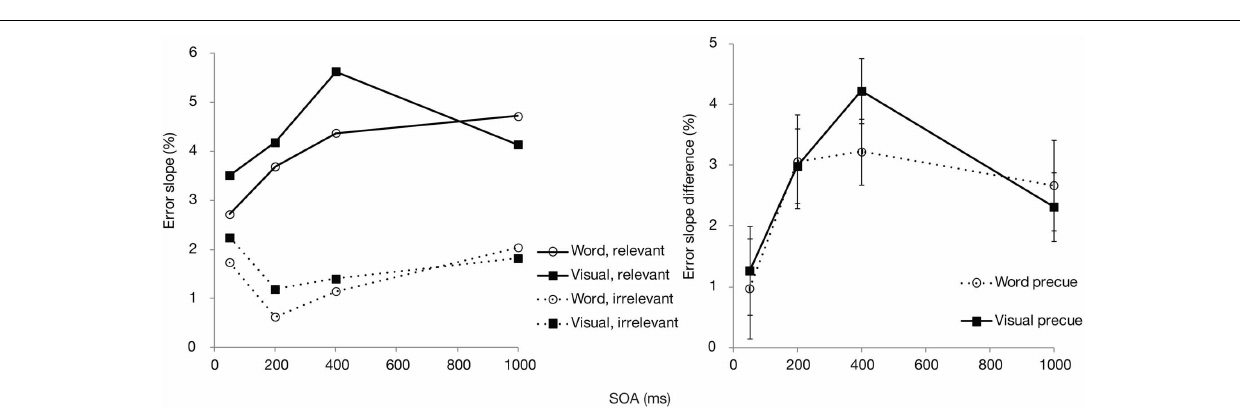
Frontiers in Psychology |